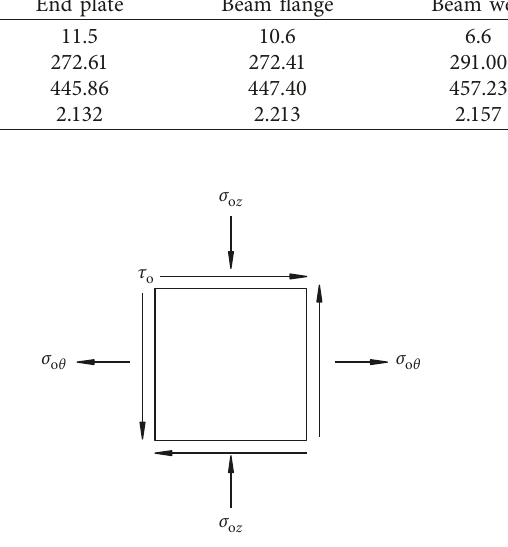
Figure 4: Stress state of steel plate of outer steel tube.